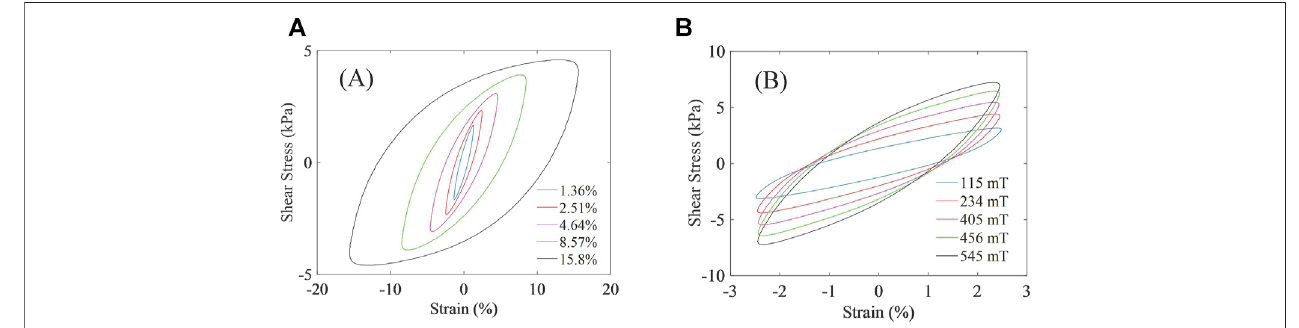
FIGURE 9 | Experimental data of MRE (A). different strain amplitudes and (B) different magnetic fl ux density.